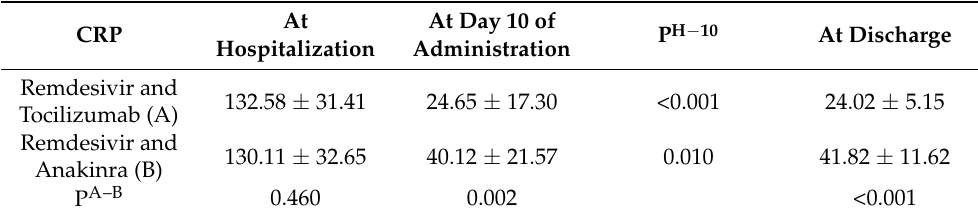
Table 5. Evaluation of